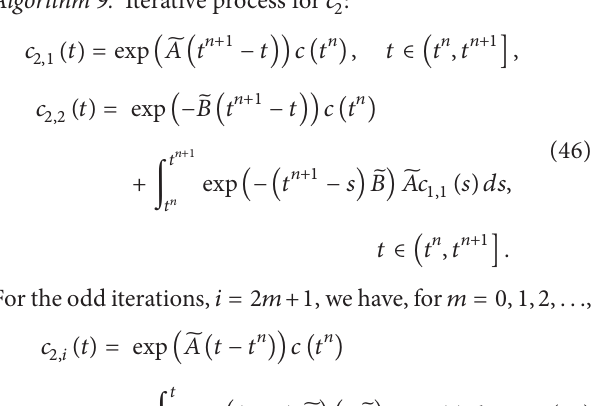
Algorithm 9. Iterative process for 𝑐 2 :